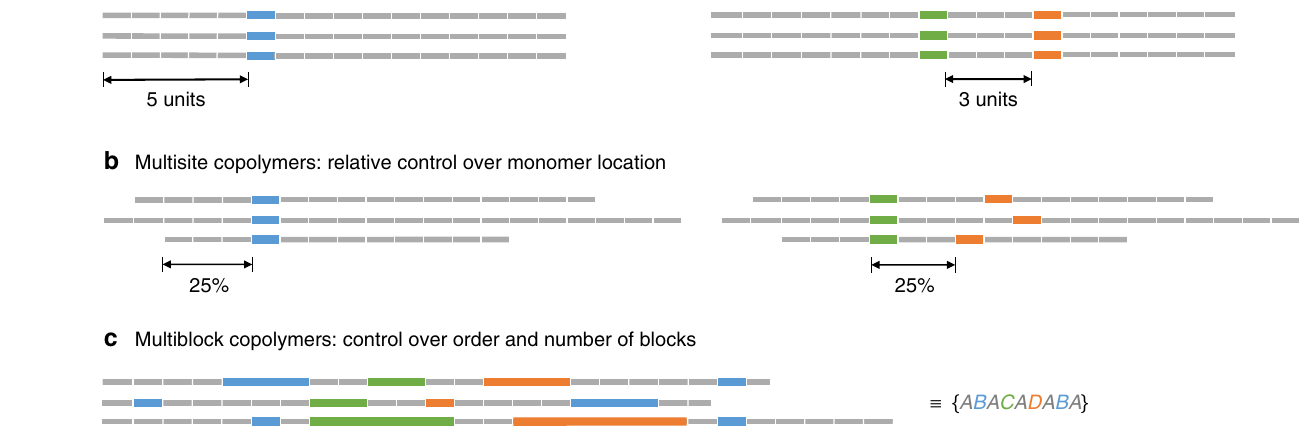
Figure 1 | Some aims of precision polymer synthesis. ( a ) Absolute control of monomer position and/or separation in a sequence-defined copolymer. ( b ) Relative control of monomer position and/or separation in a multisite copolymer. ( c ) Control of number and order of blocks in a multiblock copolymer. Throughout this paper, the letters A , B , C and D refer to different types of monomer. A collection of polymer chains containing on average n units of A followed by m units of B is represented as { A n B m }, whereas a single polymer chain containing exactly N units of A followed by M units of B is represented as A N B M